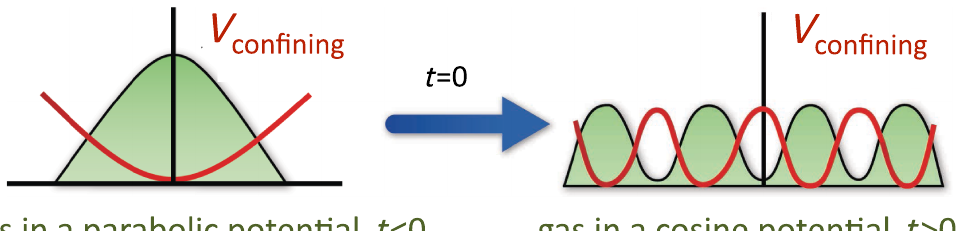
FIG. 1. Quench protocol : We prepare the one-dimensional Bose gas in its ground state in a harmonic trap. At time t ¼ 0 , we release the gas into a cosine potential and track the subsequent dynamics. The shaded green regions are illustrations of the equilibrium density profiles of the gas in the presence of the confining potentials.